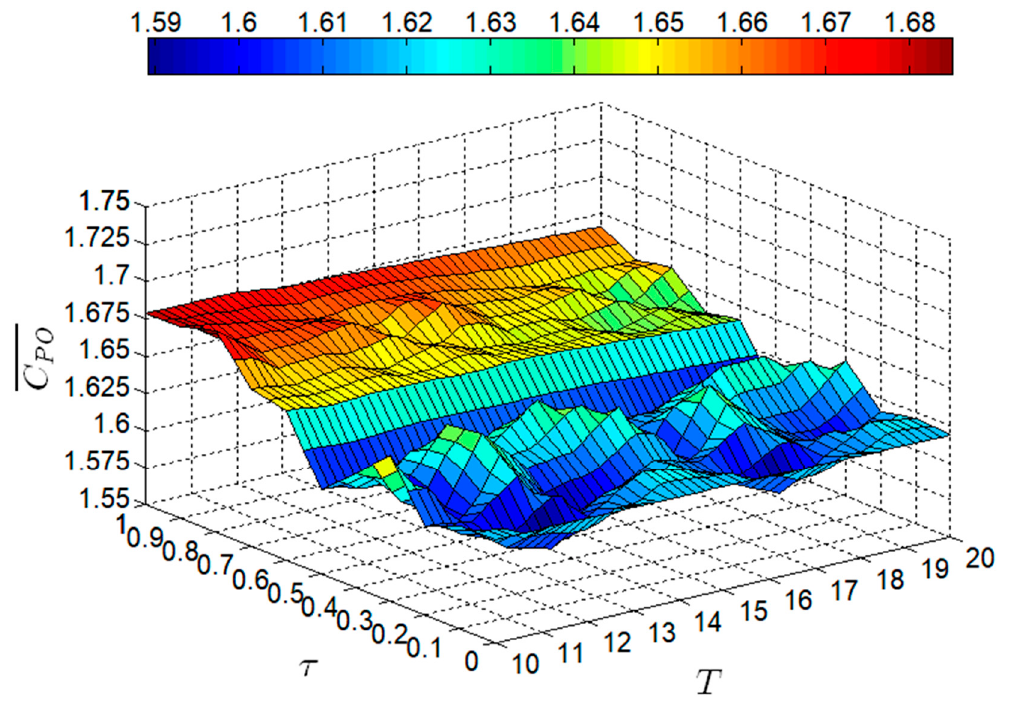
Figure 7. The variation of the mean propulsion power coe ffi cient in di ff erent periods and oscillating frequency coe ffi cients for f ∗ = 0.34, θ 0 = 10 ° .